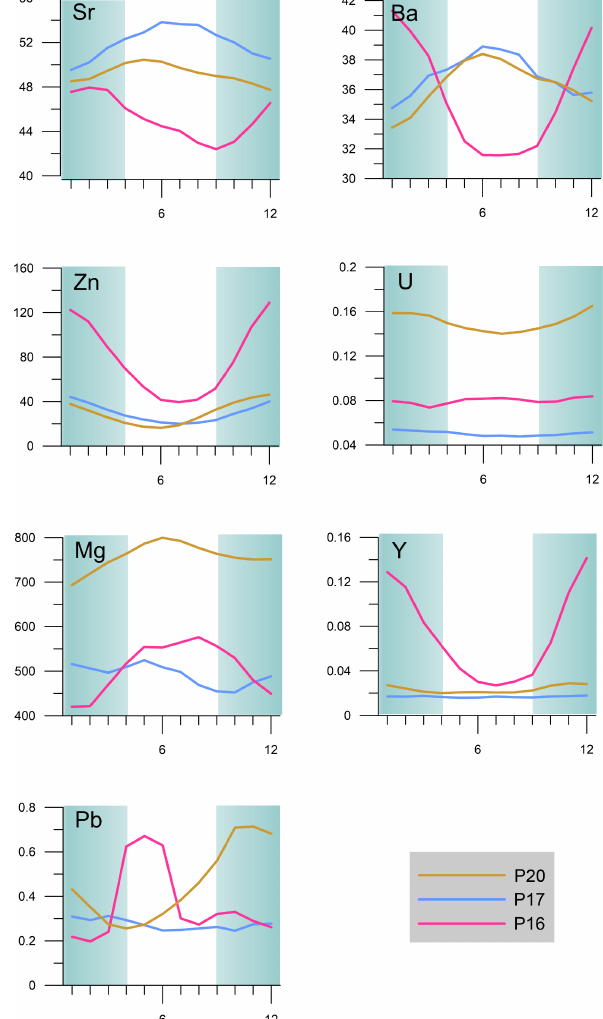
Figure 7. Annual stacks of the trace-element proxies. Y axis: con- centrations (µgg − 1 ); x axis: sub-annual increment (1 represents January, 12 represents December). Blue shaded areas indicate the winter season. For the years used, see Fig.